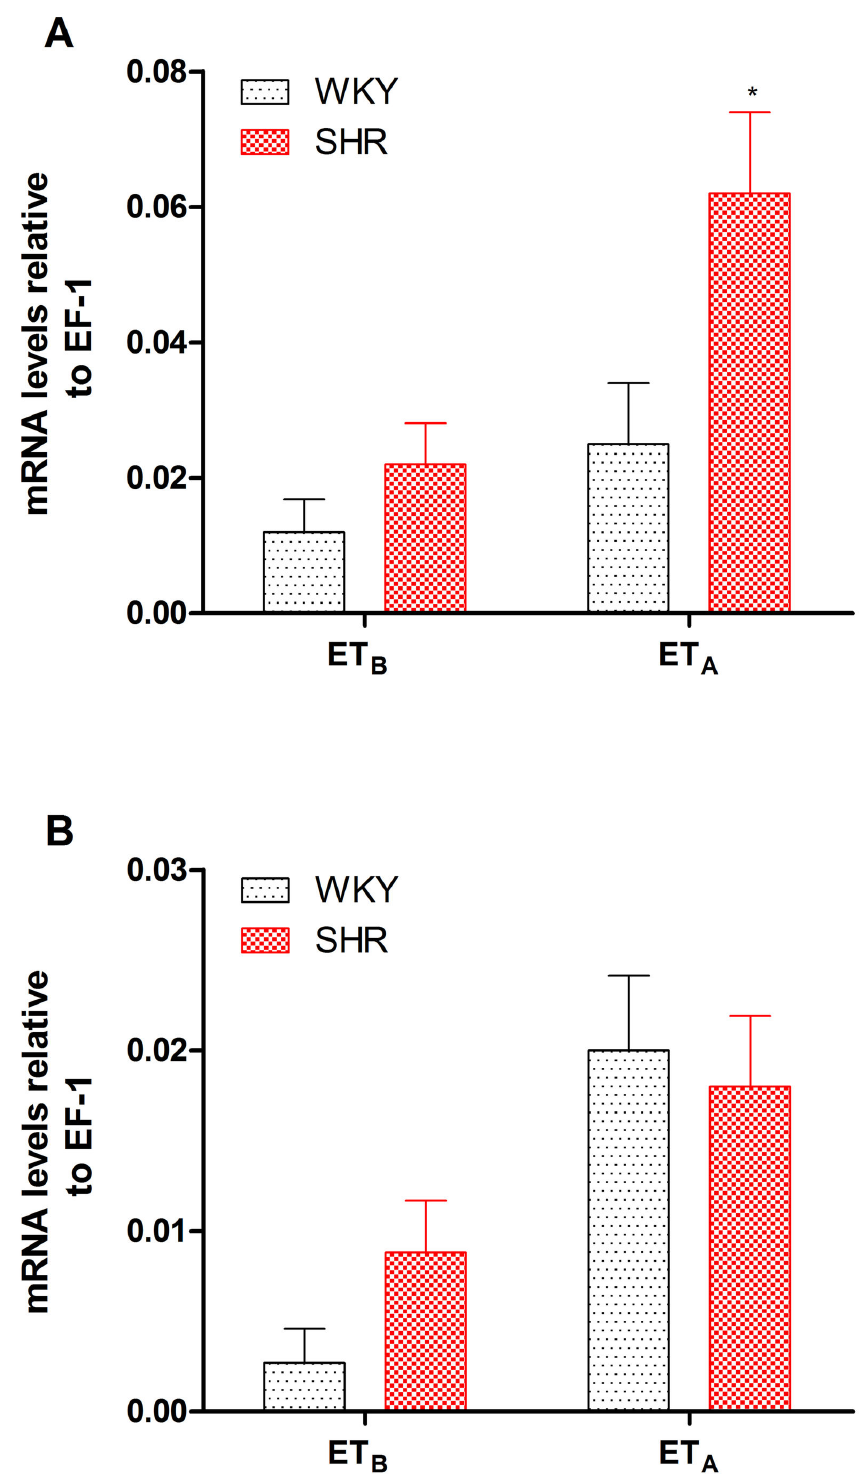
Figure 2. ET and ET receptor mRNA expression levels in SHR and WKY cerebral (A) and coronary (B) arteries. ET B A ET receptor mRNA levels were expressed relative to elongation factor-1 (EF-1) levels. Each data point is derived from 7–8 animals, A and the data are expressed as the mean ± SEM. Statistical analysis was performed using an unpaired Student’s t -test. * P <0.05 vs . WKY group. doi: 10.1371/journal.pone.0073761.g002 PLOS ONE |